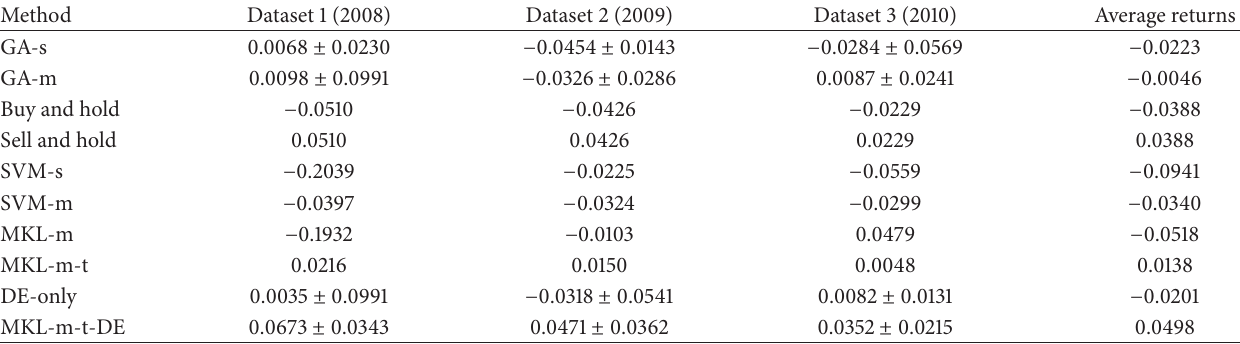
Table 10: Returns with the methods tested (The numbers right to ± is the standard